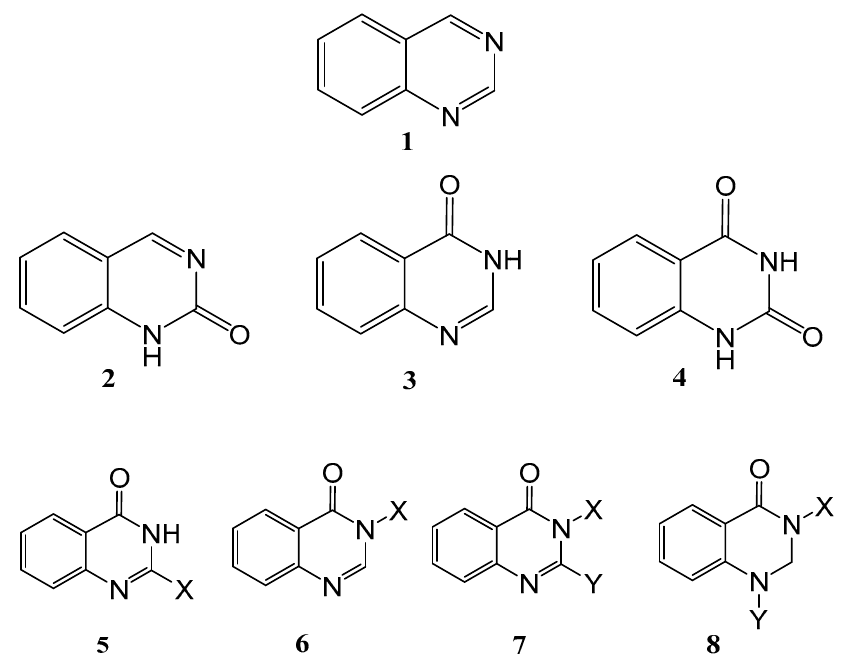
Figure 1 . Classification of quinazolines. Figure 1. Classification of